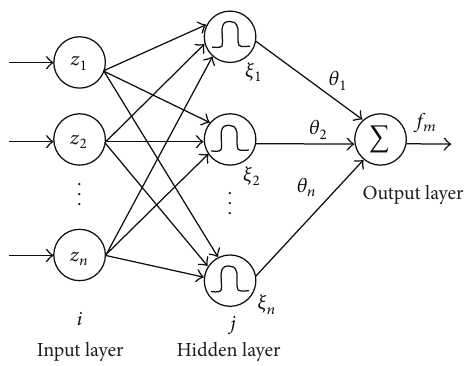
Figure 4: The structure of the